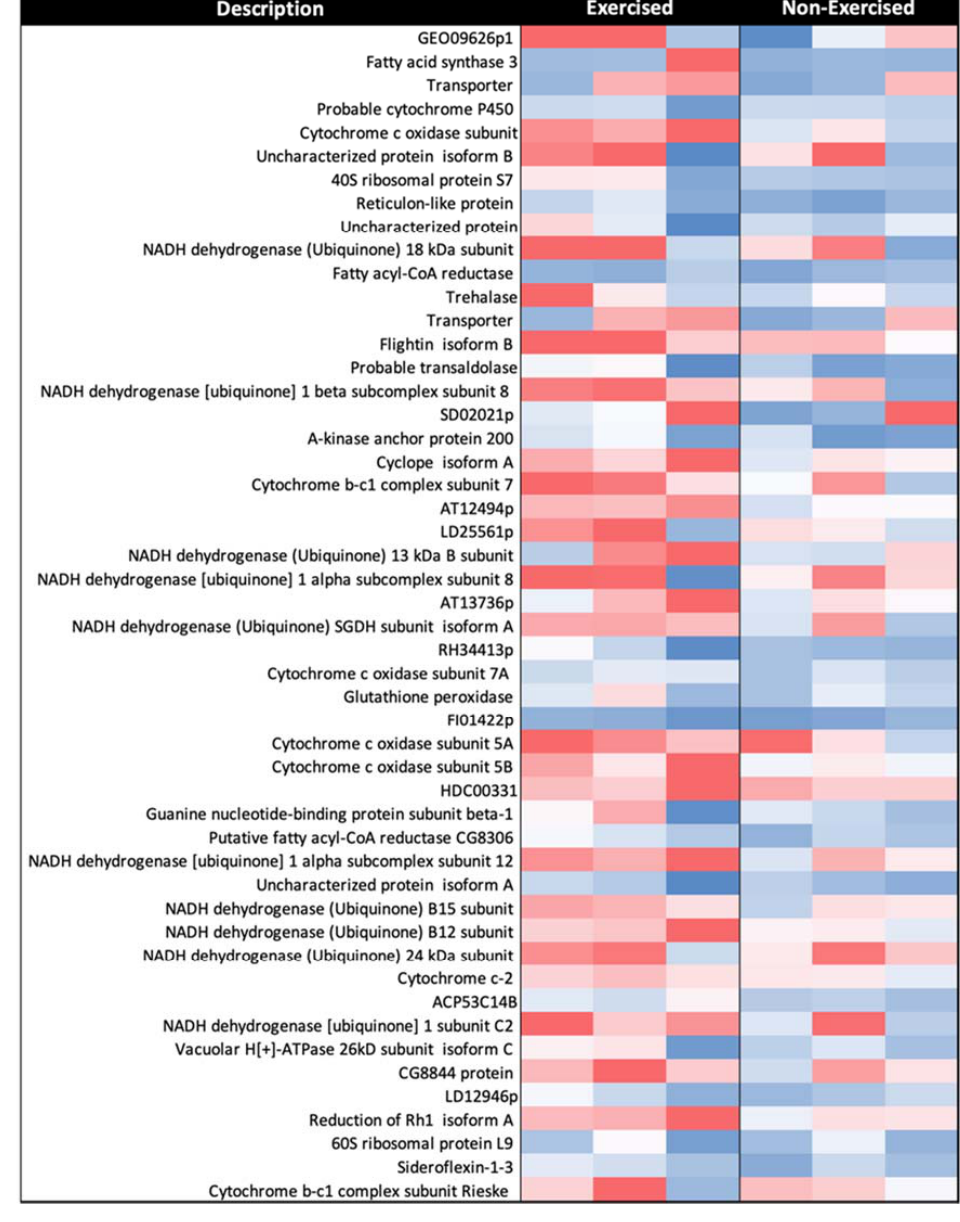
Figure 5. Representative heatmap of mitochondrial proteins with increased abundance (RAR of > 1.5) after 1 week of exercise in D. melanogaster ( n = 3). Red-to-blue colour gradient represents high-to-low relative protein abundance. The proteomic approach used was label-free mass spectrometry. All proteins listed were classified as significant as per the criteria described in the results.